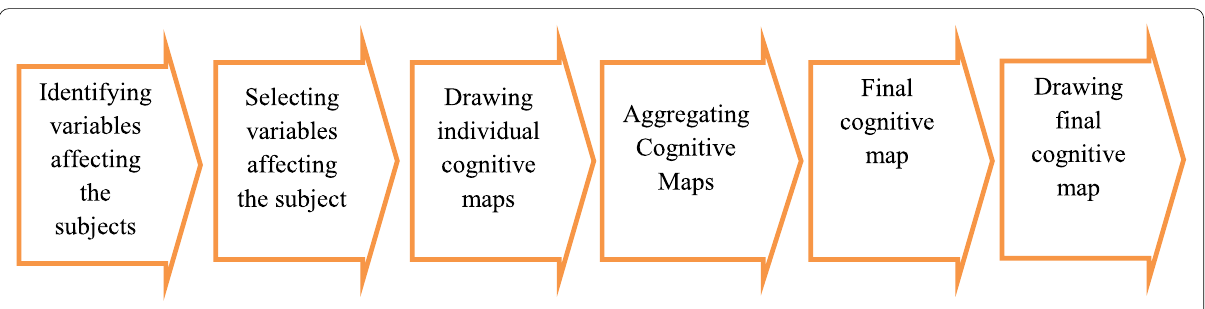
Fig. 3 Flowchart proposed method for main foresight